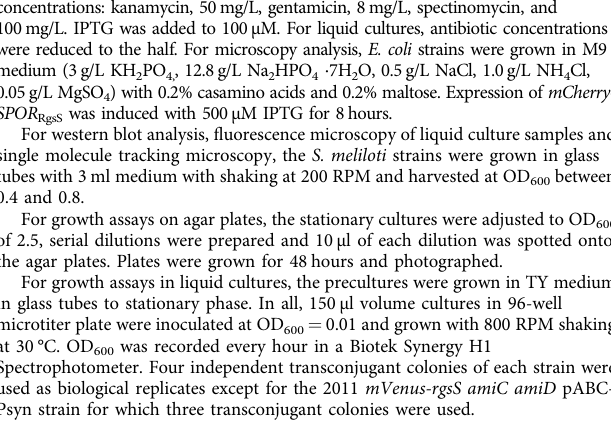
acrylamide:bisacrylamide 37.5:1 (Supplementary Fig. 9), ammonium persulfate 0.1% Temed, 0.001%; stacking gel: 0.125 M Tris-HCl pH 6.8 0.1% SDS, 6% acry- lamide:bisacrylamide 37.5:1 (Fig. 1d and Supplementary Fig. 7) or 4% acrylamide: bisacrylamide 37.5:1 (Supplementary Fig. 9), ammonium persulfate 0.1% Temed, 0.001%) that was run in the running buffer (Tris base 3.03g/L, Glycine 14,4 g/L, SDS 1g/L) and separated proteins were transferred to a PVDF membrane